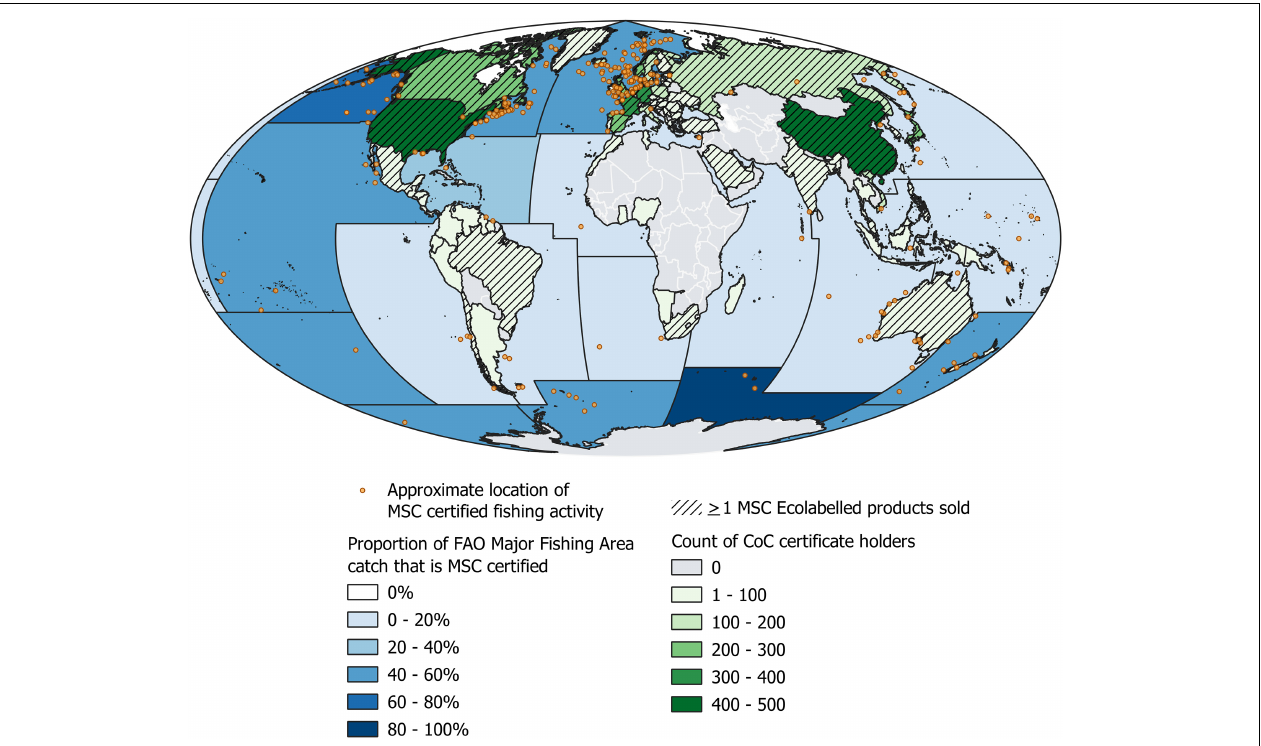
FIGURE 1 | Global distribution of MSC certificate holders at sea (fisheries) and on land (supply chain) and consumer-facing ecolabelled products sold. Count of Chain of Custody (CoC) certificate holders per country as of 15 September 2020, eco-labeled products sold from 1 April 2019 through 31 March 2020, certified fishery reported landings as of 31 March 2020 as a proportion of FAO 2018 marine capture per FAO major fishing area (UN World Food and Agriculture Organization [FAO], 2020d), excluding inland, farmed, plants and mammals. Approximate centroid point locations for MSC certified fisheries (https://fisheries.msc.org/en/fisheries/) as of 31 March 2020. Data description available at Marine Stewardship Council [MSC]